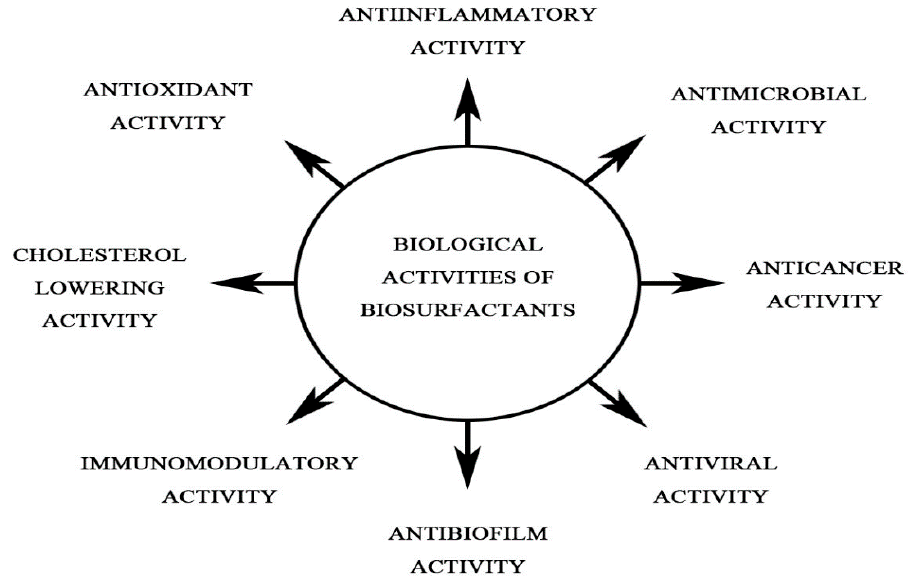
Figure 1. Biological activities of biosurfactants.